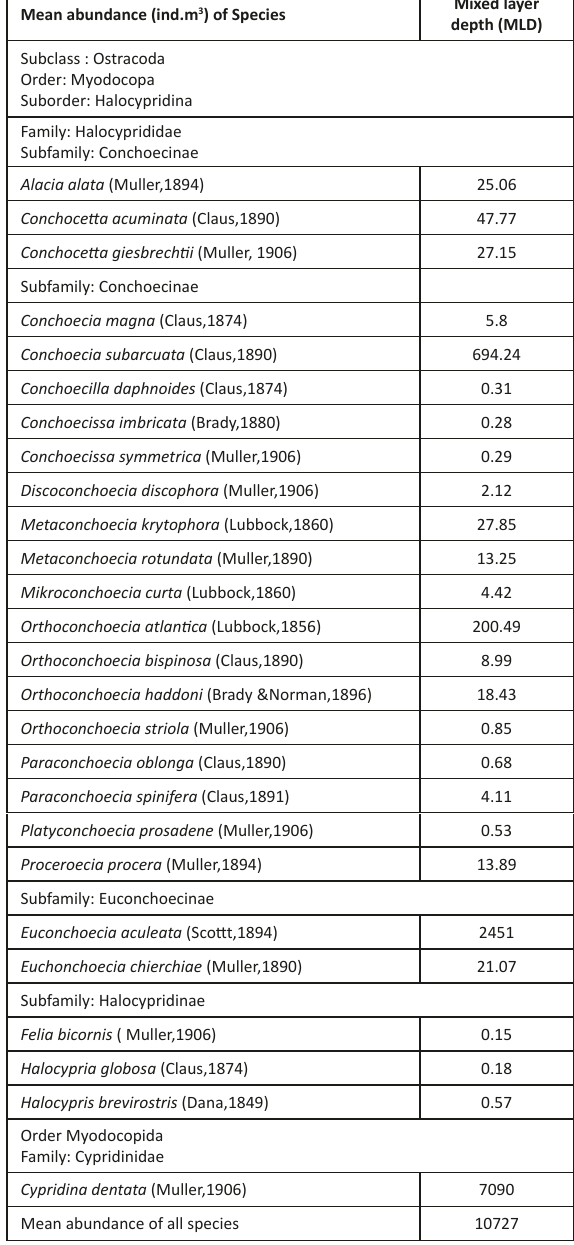
Table 2. Mean abundance of ostracod species (ind.m 3 ) in the mixed layer depth (MLD) of Arabian Sea during the summer monsoon Mean abundance (ind.m 3 ) of Species